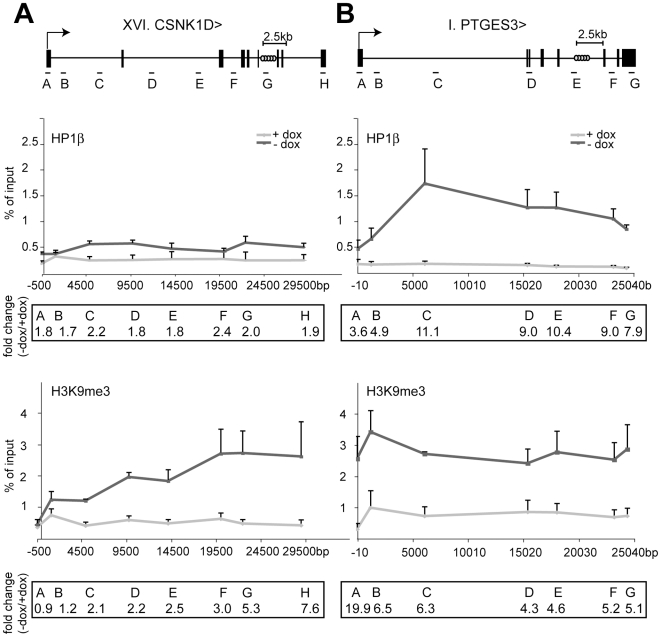
HP1β and H3K9me3 spread from the KRAB–binding site to the promoter.ChIP analyses quantifying the relative enrichment (% of input) of both H3K9me3 and HP1β were performed for the irrepressible clone XVI and the repressible clone I in the presence and absence of dox. The interrogated sequence spanned from the proviral tTRKRAB binding sites (light grey circles) to the indicated trapped promoters. (A) Enrichments of both modifications at the trapped casein kinase 1d (CSNK1D) locus. (B) Enrichments of both modifications at the prostaglandin E synthase 3 (PTGES3) locus. qPCR amplicons are depicted as letters and are not drawn to scale. All values are expressed as means +SEM of triplicate experiments. Fold changes were calculated as ratios of -dox/+dox enrichments, with the ratios of the respective positive controls set as 1. The controls consisted of p53BP2 for H3K9me3 and of ZNF556 for HP1β (Table S4).